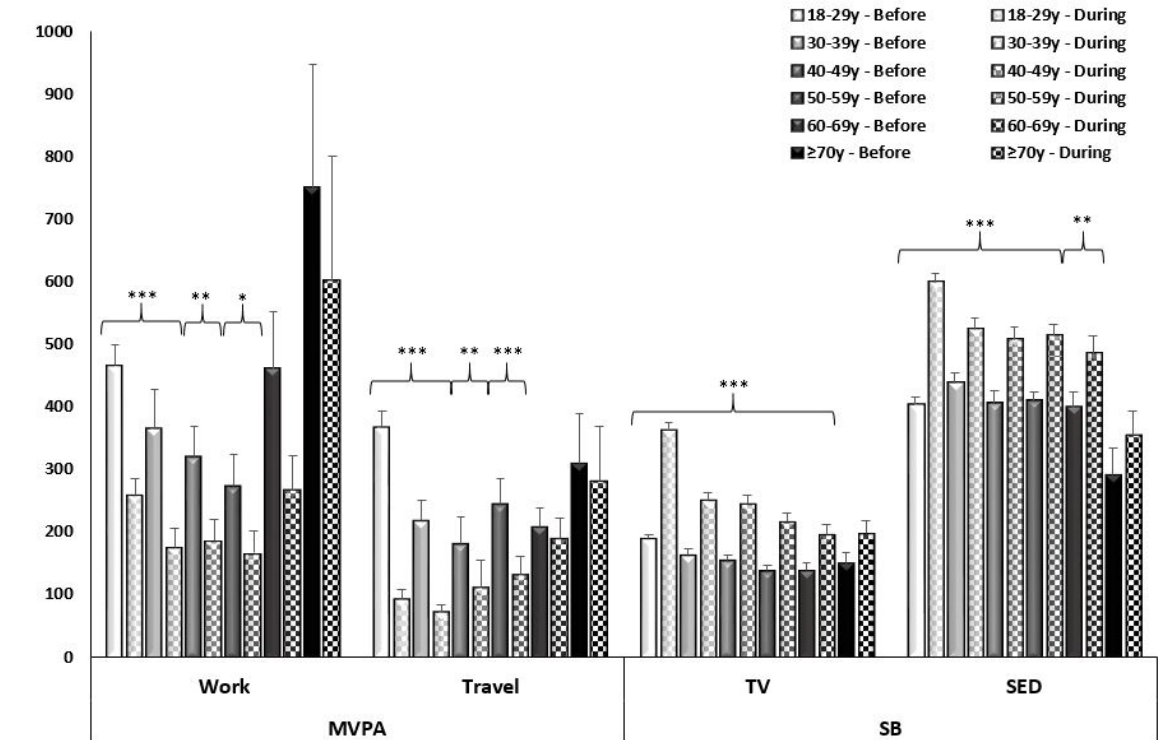
Figure 2. Average weekly self-reported time (minutes) spent in moderate-to-vigorous physical activity (MVPA) related to work and travel and time spent in sedentary behaviors (watching TV and sitting) separated by age group. Significant difference within age group by time point (*** adj. p < 0.0001; ** adj. p < 0.001; * adj. p <